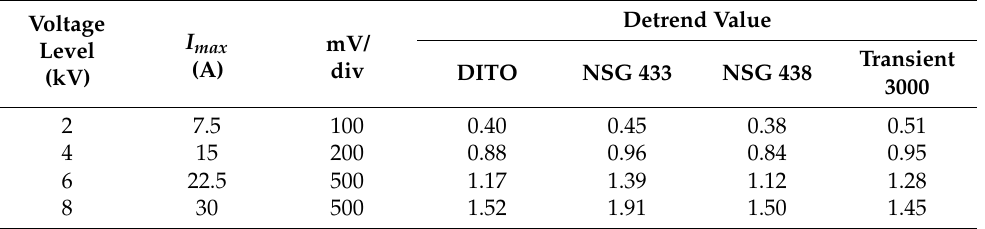
Table 2. Detrend values for different test levels and ESD test generators [19] .